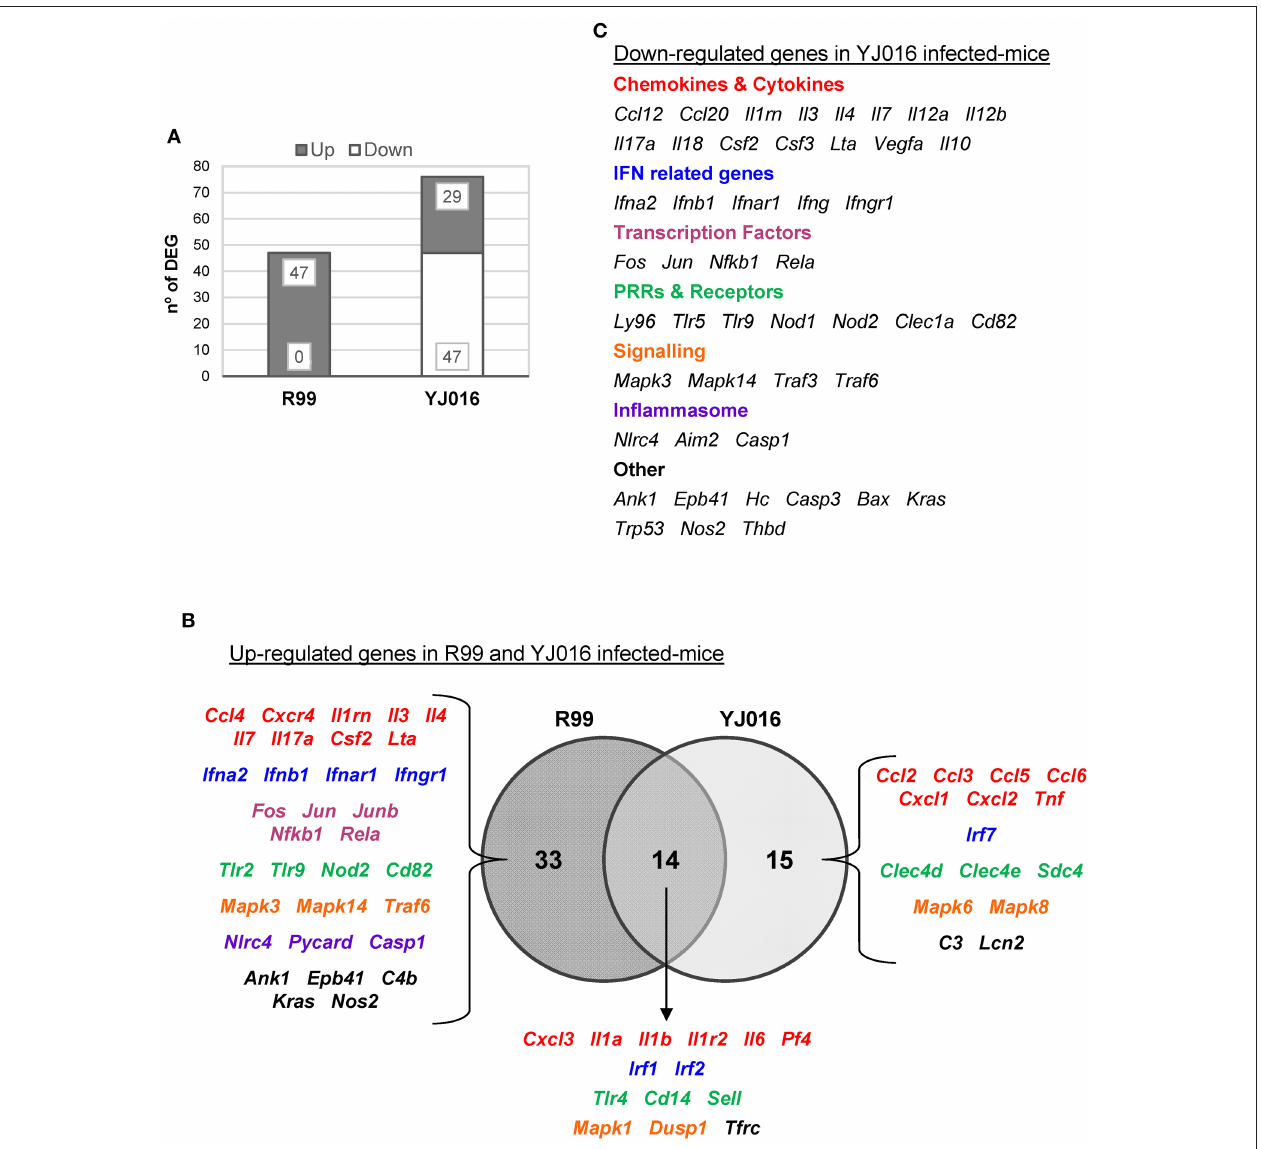
FIGURE 5 | Bt1-RtxA1 1 and Bt2-SerE elicit a different immune response. (A) Number of genes up- and down-regulated in mice infected with the Bt2-SerE R99 strain and the Bt1-RtxA1 1 YJ016 strain. (B) Venn diagram depicting the overlap of the up-regulated genes in response to R99 and YJ016 strain when compared with uninfected mice. (C) List of genes down-regulated after the infection with the Bt1-RtxA1 1 YJ016 strain. In all cases, only genes up-regulated more than 1.3 or down-regulated more than 0.5 were